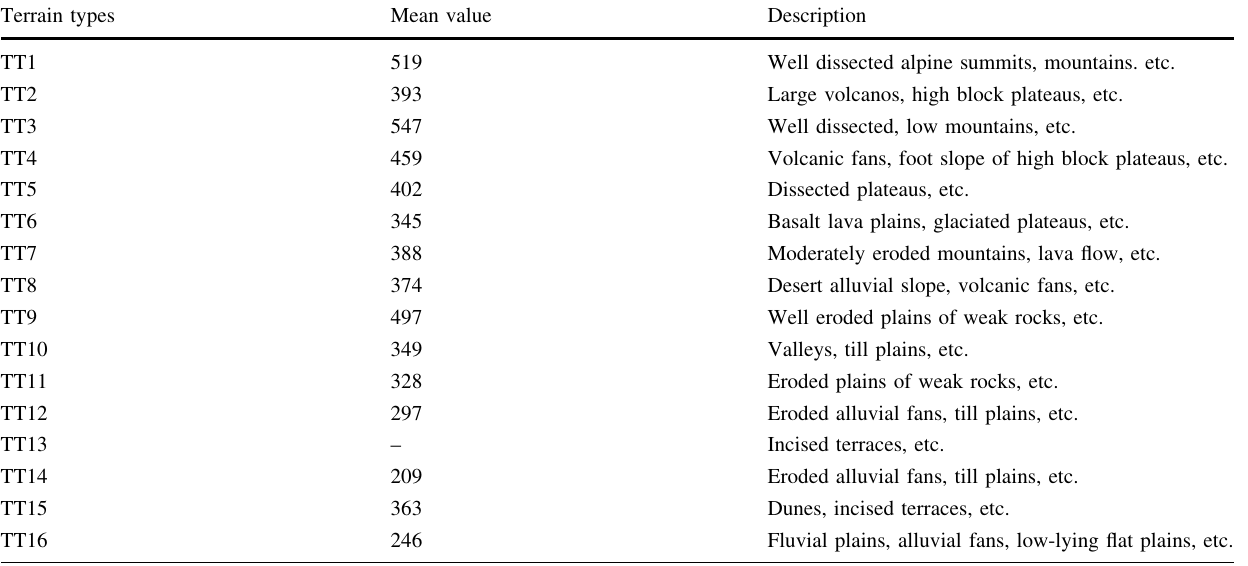
Table 5 16 types of terrain and corresponding mean V s30 values. Source : Yong et al. (2012) Terrain